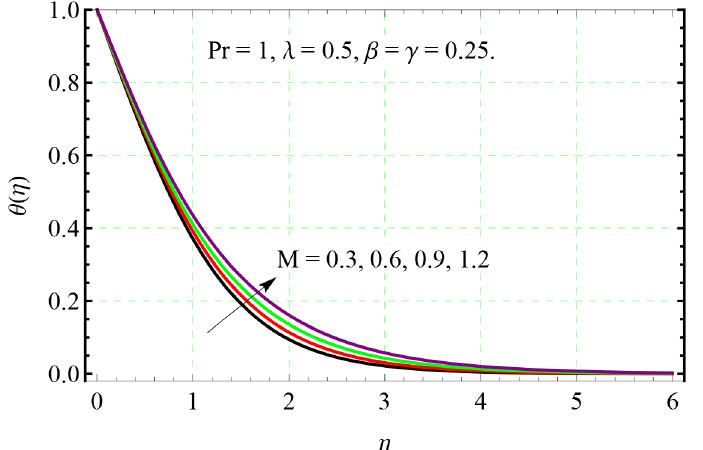
Fig 9. Effect of M on θ ( η ).